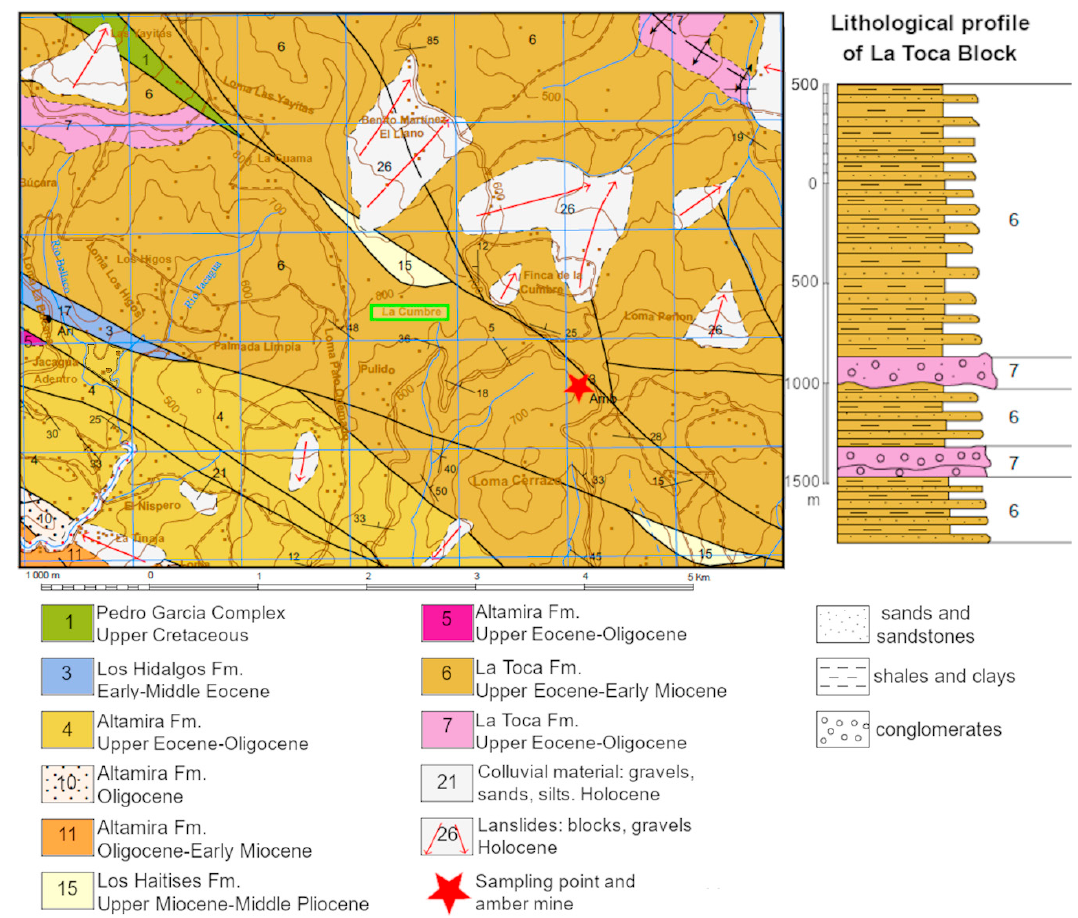
Figure 2. Geological map with the location of the sampling site in La Cumbre mine, based on the Geological Map of the Dominican Republic at 1:50 000 scale (San Francisco Above (sheet 6074-I)) [47]. Legend: 1—Volcanoclastic, pyroclastic and subvolcanic rocks, 3—Recrystallized limestones, 4—Alternation of sandstones and clays, local conglomerates, 5—Breccias and conglomerates with andesites and limestones, 6—Rhythmic alternations of sandstones and clays, 7—Conglomerates, 10—Polymictic conglomerates, 11—Rhythmic alternations of sandstones and clays, 15—Micritic limestones and reef limestones.